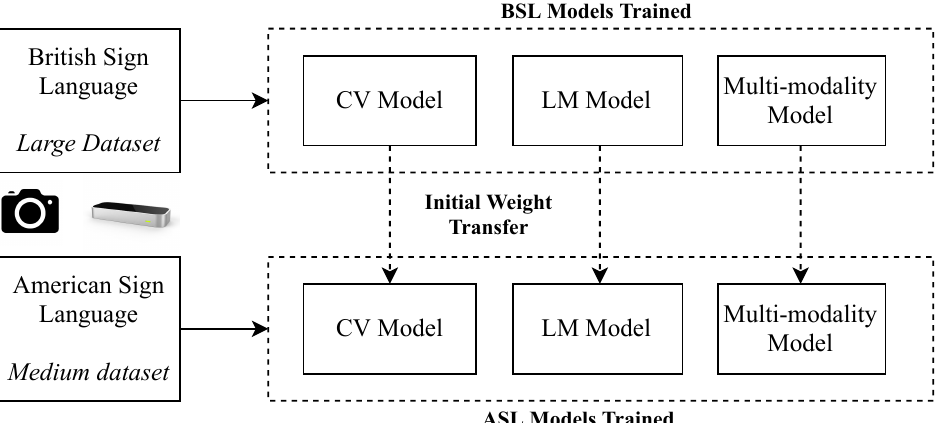
Figure 9. Transfer Learning Experiments which train on BSL and produce initial starting weight distributions for the ASL